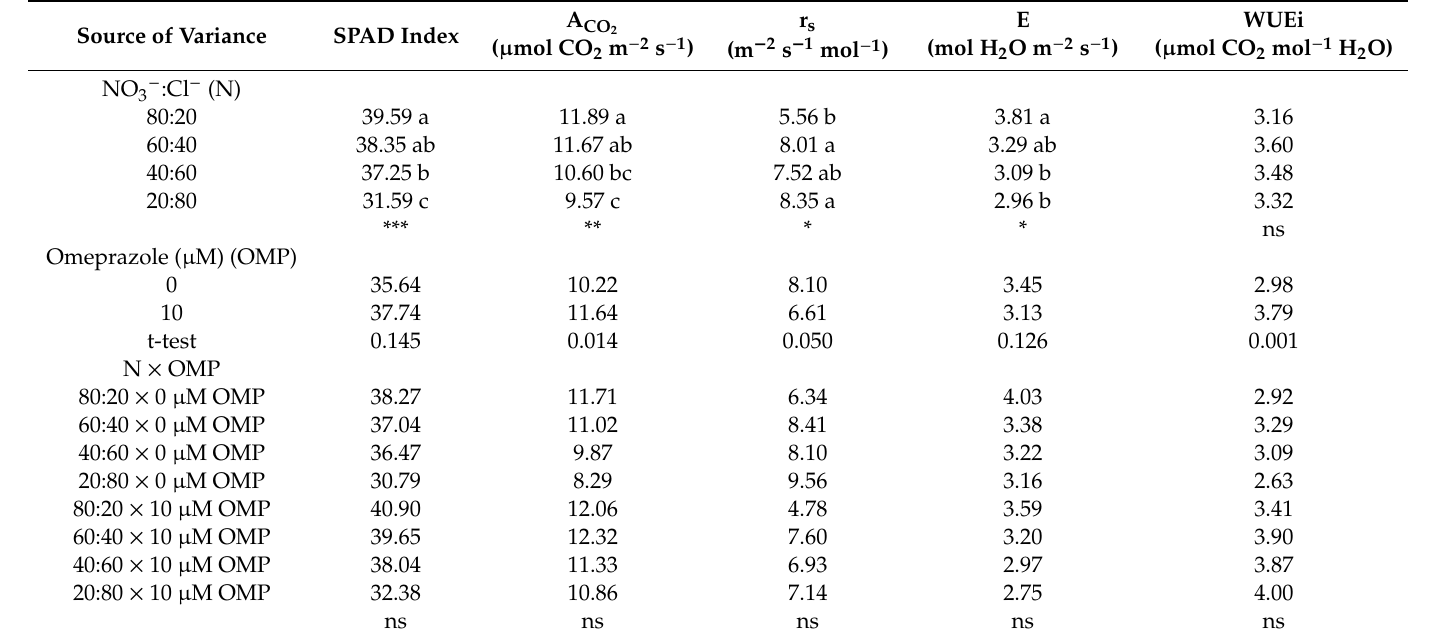
Table 2. E ff ects NO 3 − :Cl − ratio in the nutrient solution and omeprazole (OMP) application rates on physiological parameters: SPAD index, net CO 2 assimilation ), stomatal resistance (r s ), transpiration rate (E) and instantaneous water use e ffi ciency (WUE i ) of greenhouse hydroponic basil plants. (A CO 2 Source of